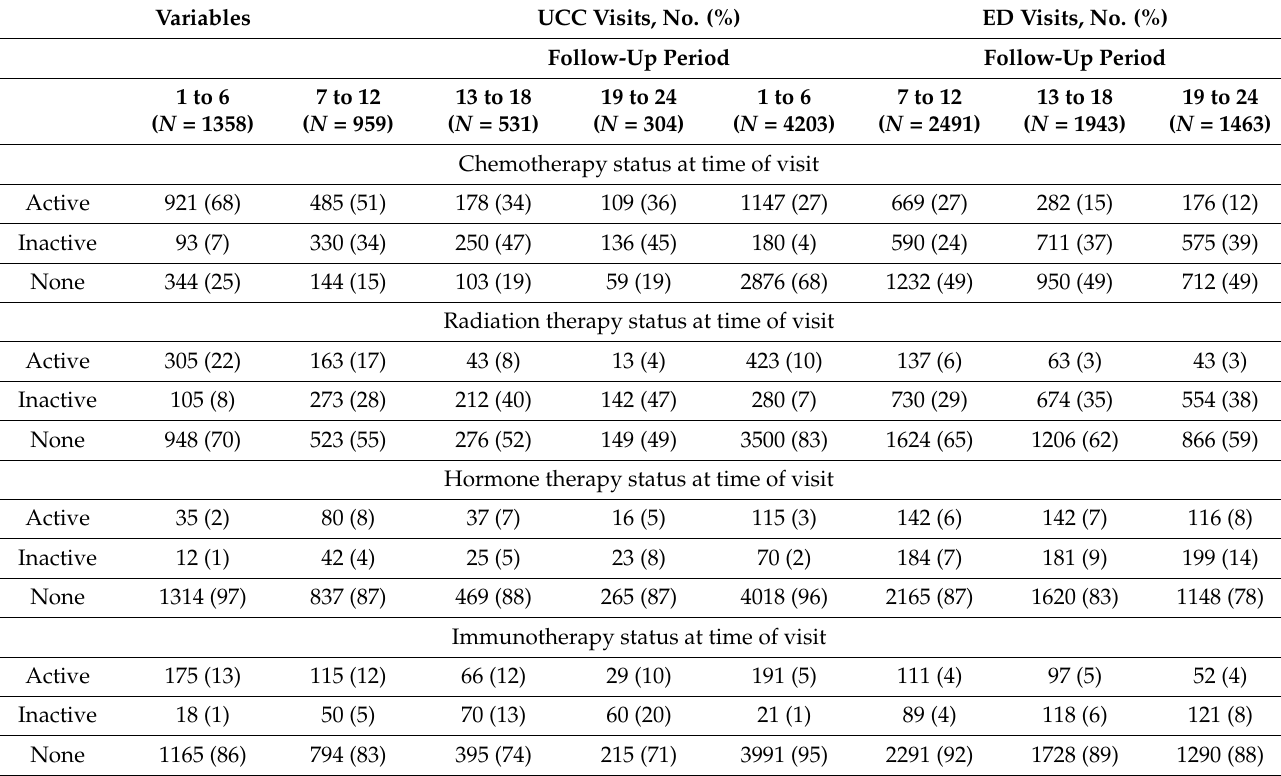
Table 1. Comparison of individuals who visited the Urgent Cancer Care Clinic (UCC) or an emergency department (ED) by follow-up period, 2013–2016, Winnipeg, Manitoba ( N = 13,252